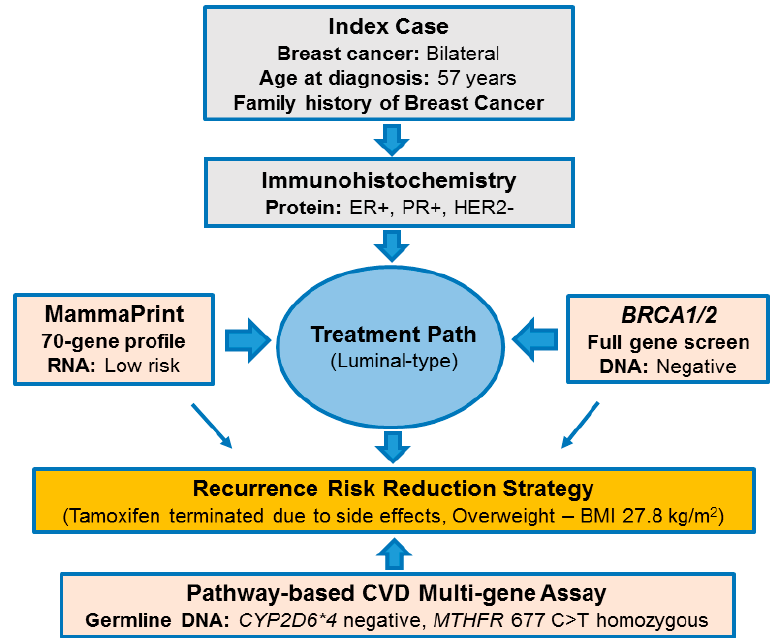
Figure 1. Outline of the pathology-supported genetic testing (PSGT) strategy used to select the index case with bilateral BRCA1/2 mutation-negative breast cancer for whole exome sequencing